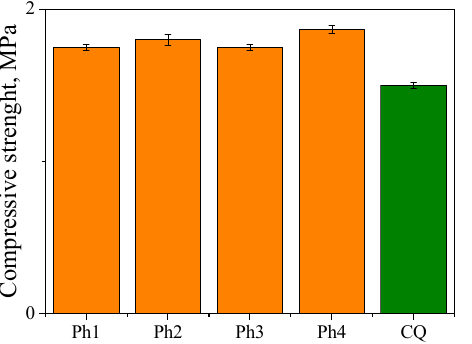
Figure 7. Dependence of the compressive strength on the type of photoinitiator: dibenzo[a,c]phen- azine (Ph1), benzo[a]phenazine (Ph2), 11 H -indeno[1,2-b]quinoxalin-11-one (Ph3), 6 H -indolo[2,3- b]quinoxaline (Ph4) and camphorquinone (CQ); co-initiator: (phenylthio)acetic acid (PhTAA); DF1– filler Ketac Fil Plus. The plot shows the mean values with standard